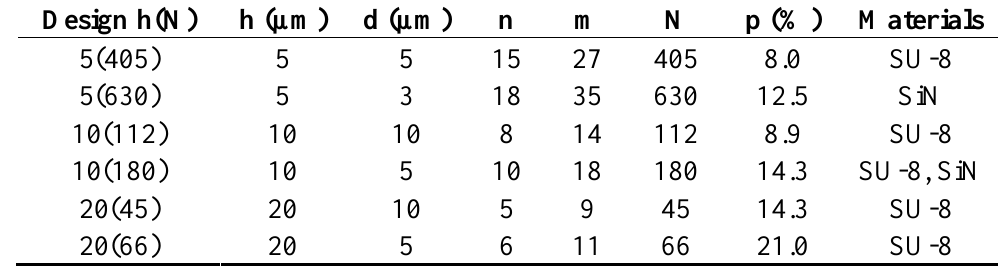
Table 1. Design parameters and materials of the fabricated flow sensors; h = hole size, d = distance between holes, n = columns in array, m = rows in array, N = number of holes, p =